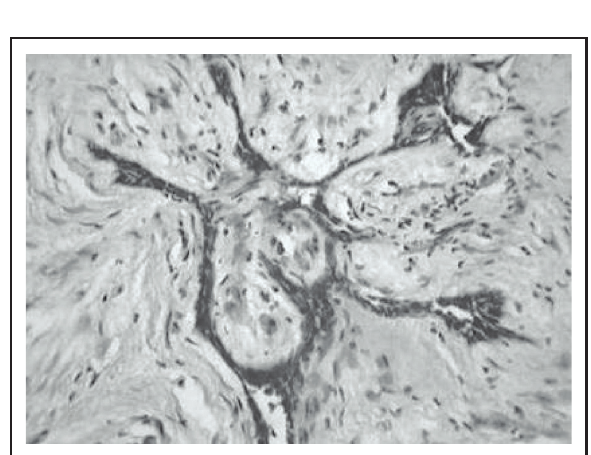
Figure 1. Panoramic radiograph shows expansile, ra - diolucent lesion with diffuse borders extending form left first molar region to right mandibular canine.